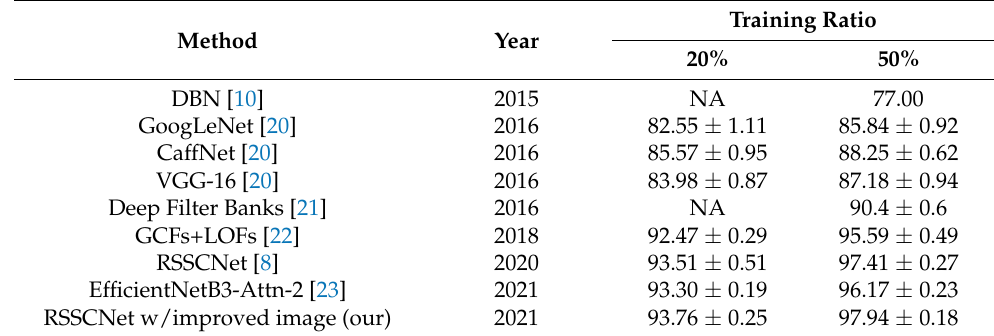
Table 9. Comparison of the overall accuracy on the RSSCN7 dataset.